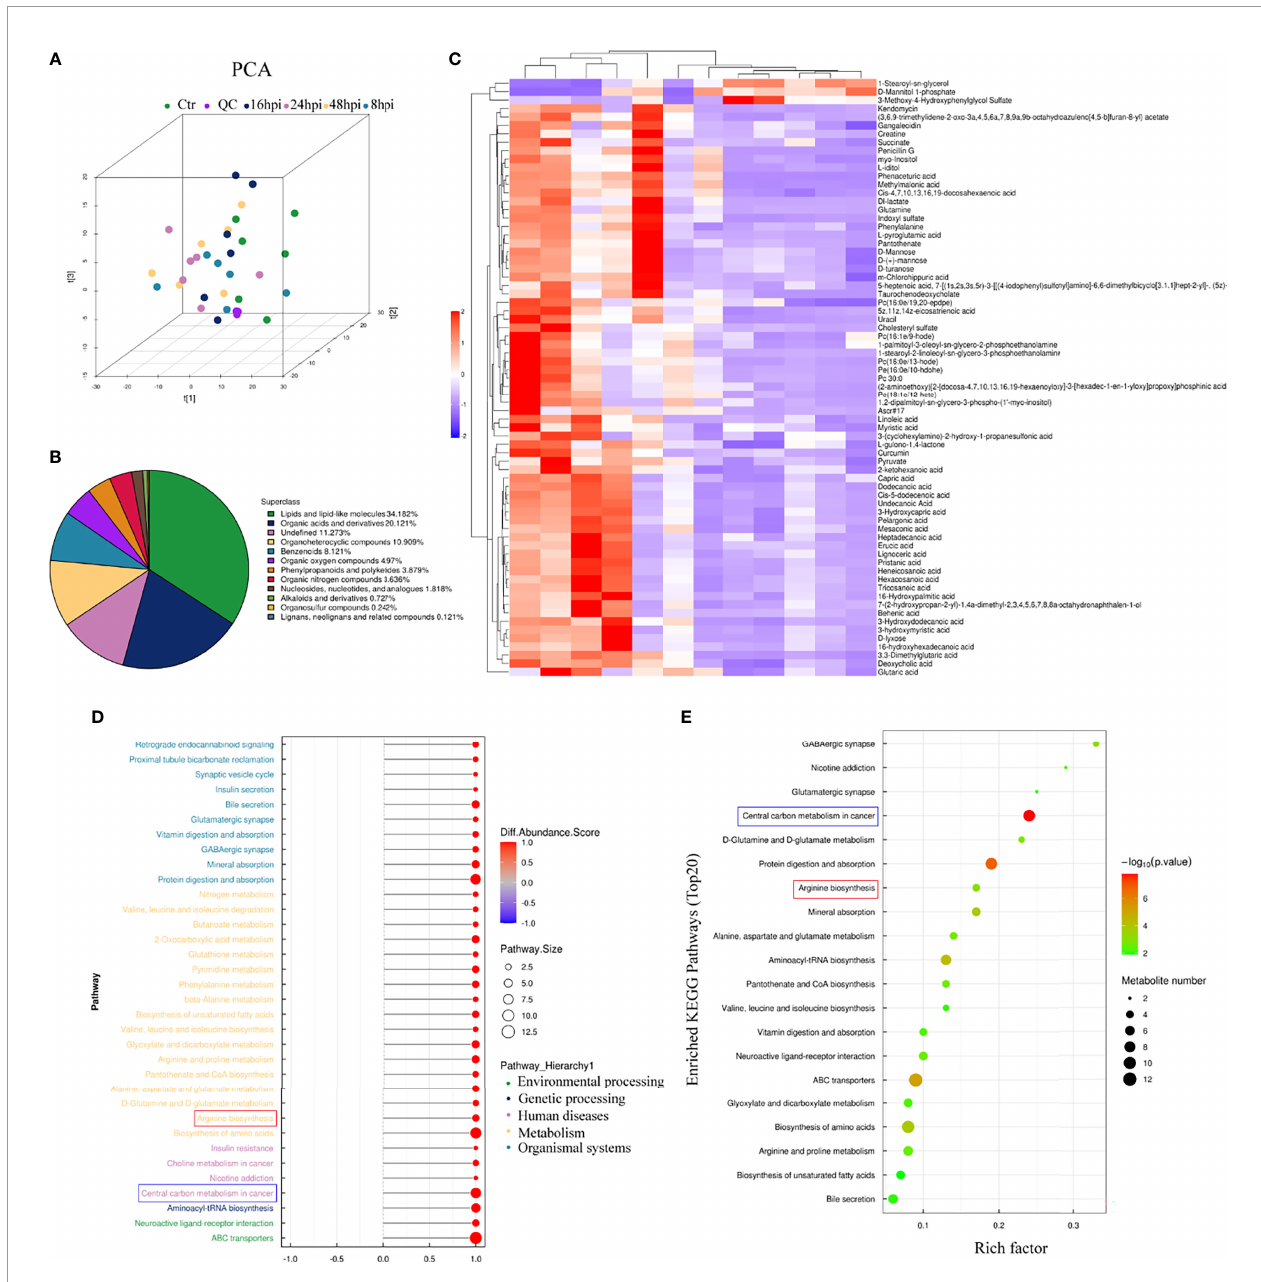
FIGURE 6 | Metabolomic analysis of H1N1-infected hNEC cells. After 8h, 24h, and 48h of H1N1 virus infection of hNEC cells, the cells were collected for High- Resolution Untargeted Metabolomics. (A) Population-Sample Principal Component Analysis (PCA) Plot for High-Resolution Untargeted Metabolomics [3D Model]. The virus-infected group at each time point had 6 cell samples from different people. (B) All identi fi ed metabolites were classi fi ed according to their chemical classi fi cation information and their proportions were counted. (C) Heat map showing all differential gene expression pro fi les of H1N1 virus-infected hNEC cells at 24h compared to control. Each column represents a hNEPCs sample from a different person. (D, E) KEGG pathway (D) and GO (E) enrichment analysis of H1N1 virus- infected hNEC cells at 24h. The color of the bar indicates -log10